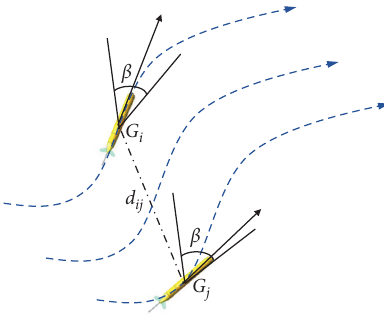
Figure 1: Schematic diagram of double glider formation moving in the ocean current.